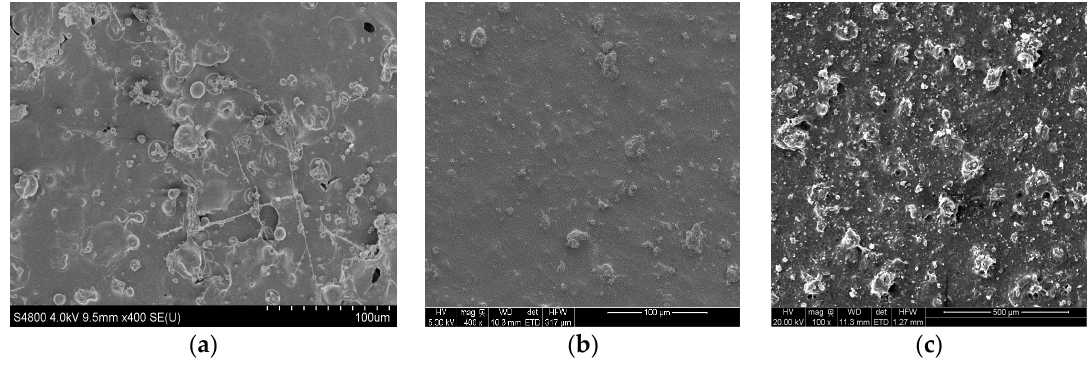
Figure 4. Surface structure of polyimide composite coatings with 10% ( a ), 20% ( b ), 30% ( c ) alumina.